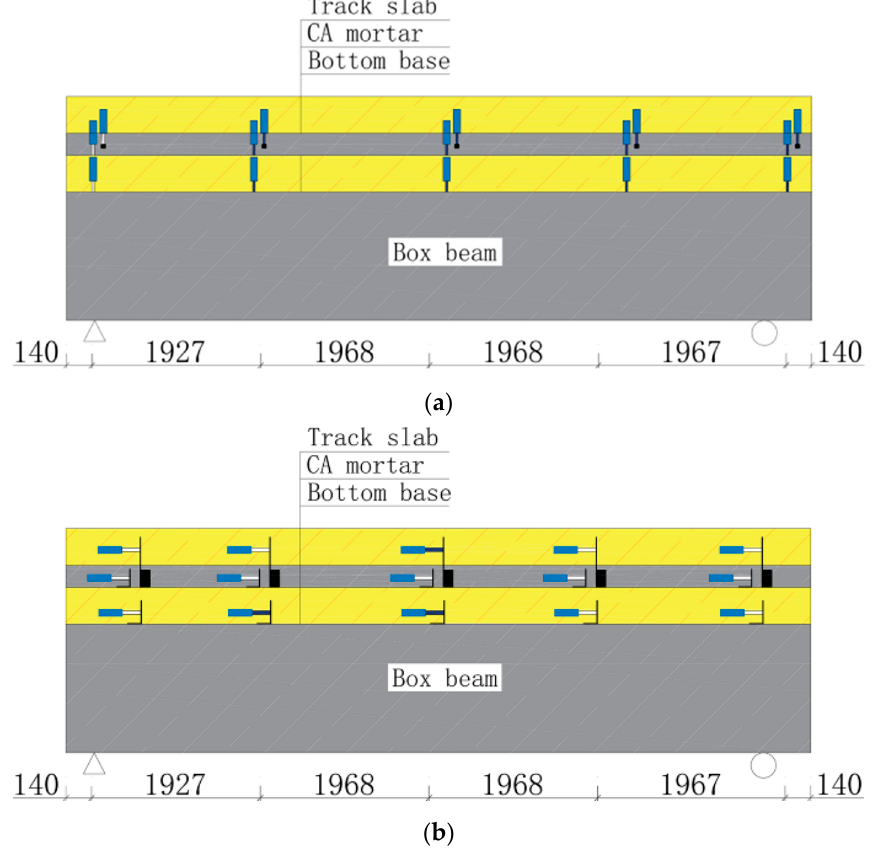
Figure 5. The layout of the linear displacement gauge (Unit: mm). ( a ) Vertical LVDT displacement meter; ( b ) Longitudinal LVDT displacement meter.